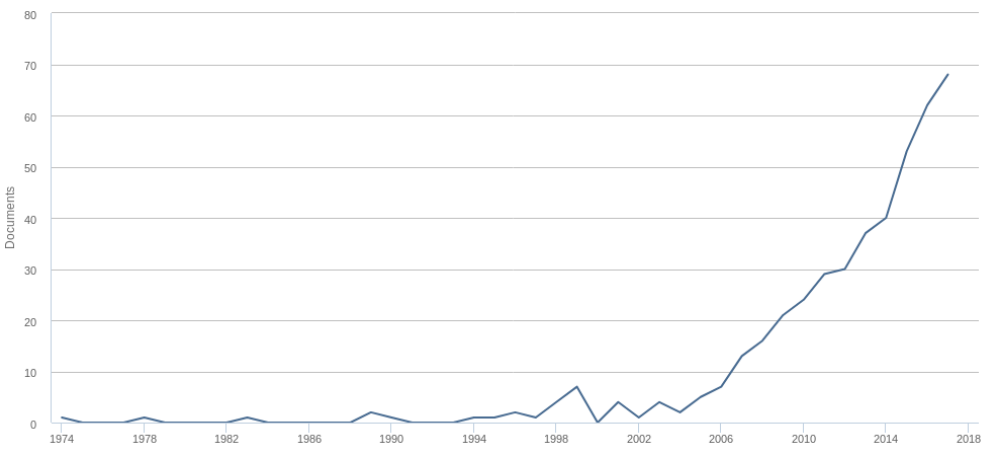
Figure 3. Distribution of number of articles per year.